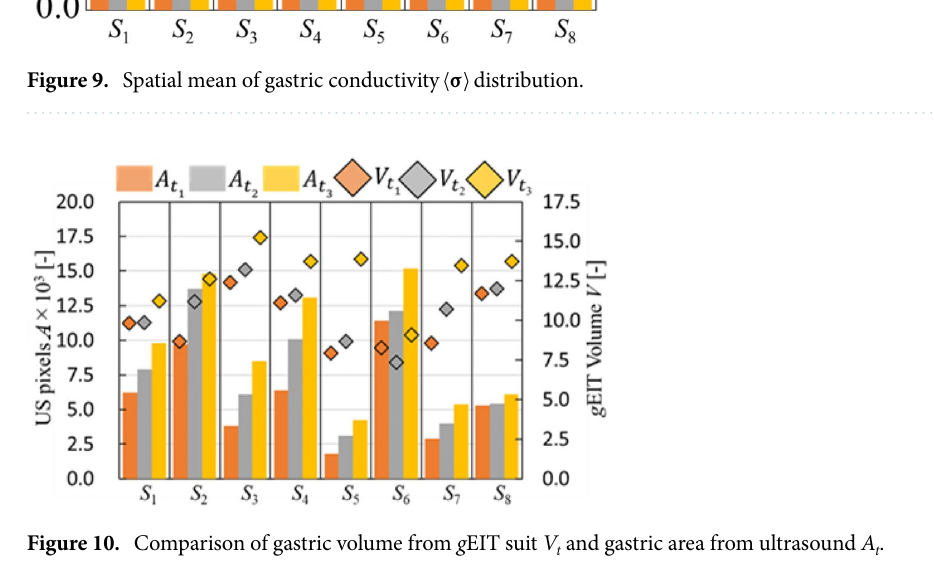
Figure 10. Comparison of gastric volume from g EIT suit V t and gastric area from ultrasound A t